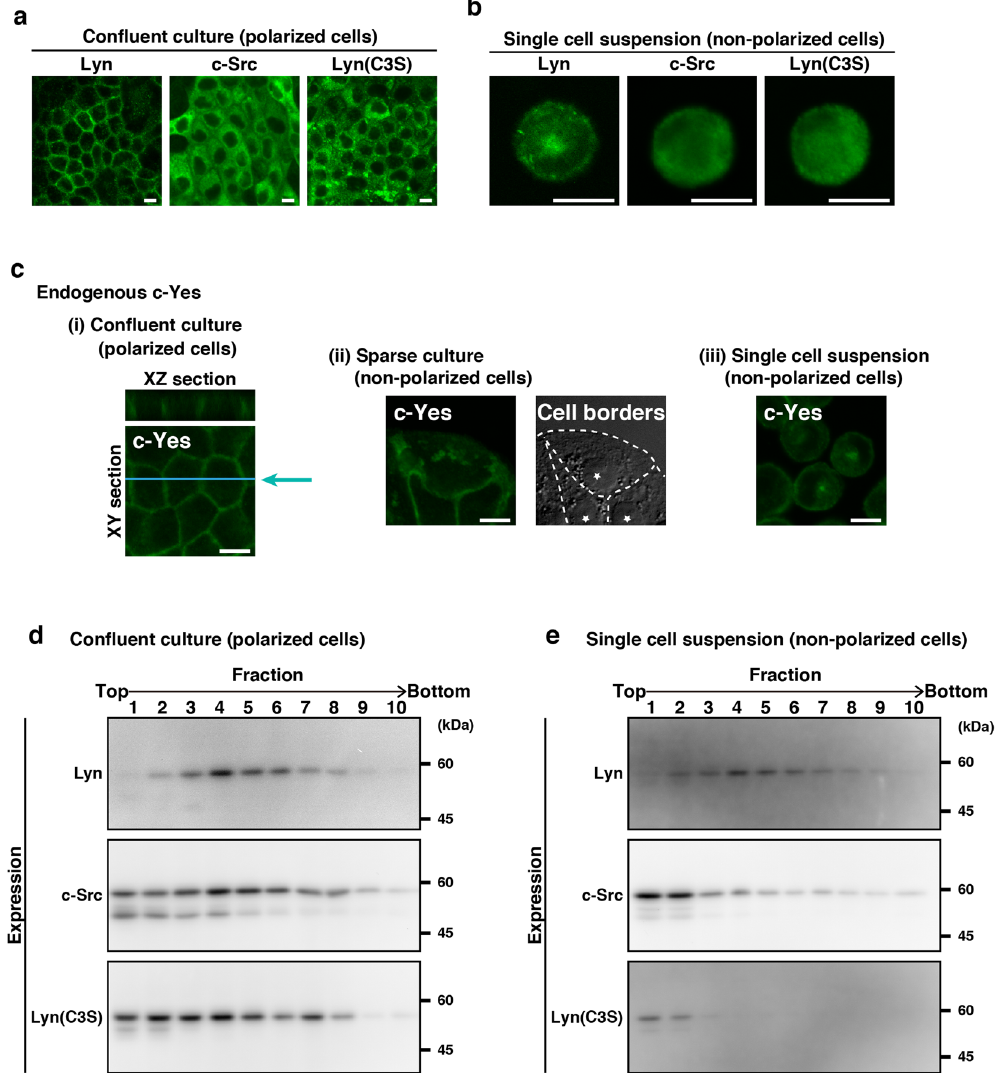
Figure 5. Role for palmitoylation of Lyn in its endomembrane localization in MDCK cells. (a , d) MDCK/ TR/Lyn, MDCK/TR/c-Src, and MDCK/TR/Lyn(C3S) cells cultured as confluent monolayers (polarized cells) were treated with 1 μ g/ml Dox for 10 h. (b , e) MDCK/TR/Lyn, MDCK/TR/c-Src, and MDCK/TR/Lyn(C3S) cells cultured to confluence (polarized cells) were treated with 1 μ g/ml Dox for 8 h, detached with trypsin and subsequently cultured in spinner flasks for 2 h. (a , b) Cells were stained with mouse monoclonal anti-Lyn or anti-c-Src antibody. Scale bars, 10 μ m. (c) Parental MDCK cells were cultured to confluence ( i , polarized cells), cultured sparsely ( ii , non-polarized cells), or cultured to confluence and subsequently cultured in suspension for 2 h ( iii , single cell suspension cultures). Cells were stained with anti-c-Yes antibody. For eye guide, cell borders and nuclei are marked by dotted lines and stars, respectively (ii) . Scale bars, 10 μ m. ( d , e) Post-nuclear supernatants obtained from polarized (d) or single cell suspension-cultured, non-polarized (e) MDCK cells were subjected to sucrose density gradient fractionation, and each fraction was analysed by Western blotting with the indicated antibodies. Molecular size markers are shown in kDa. The full-length blots are presented in Supplementary Fig.